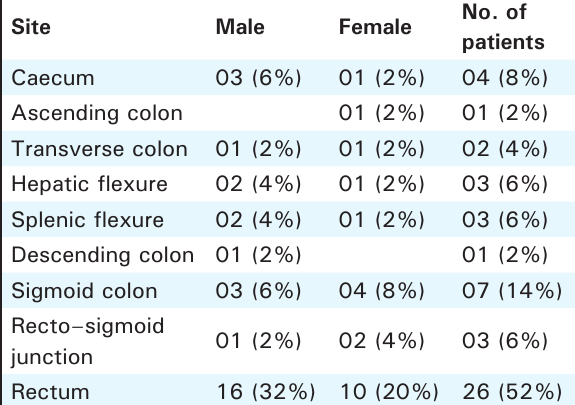
Table 3. Distribution of colorectal carcinoma according to